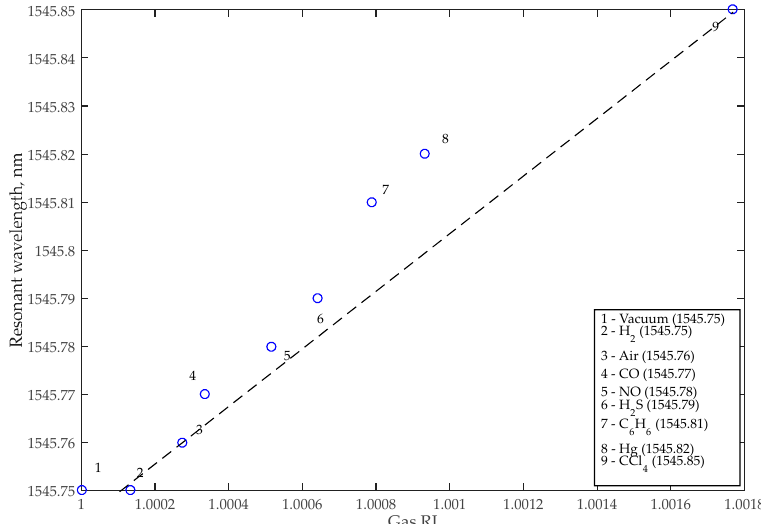
Figure 4. Relationship between ambient refractive index and resonant wavelength for the add-drop sensor.